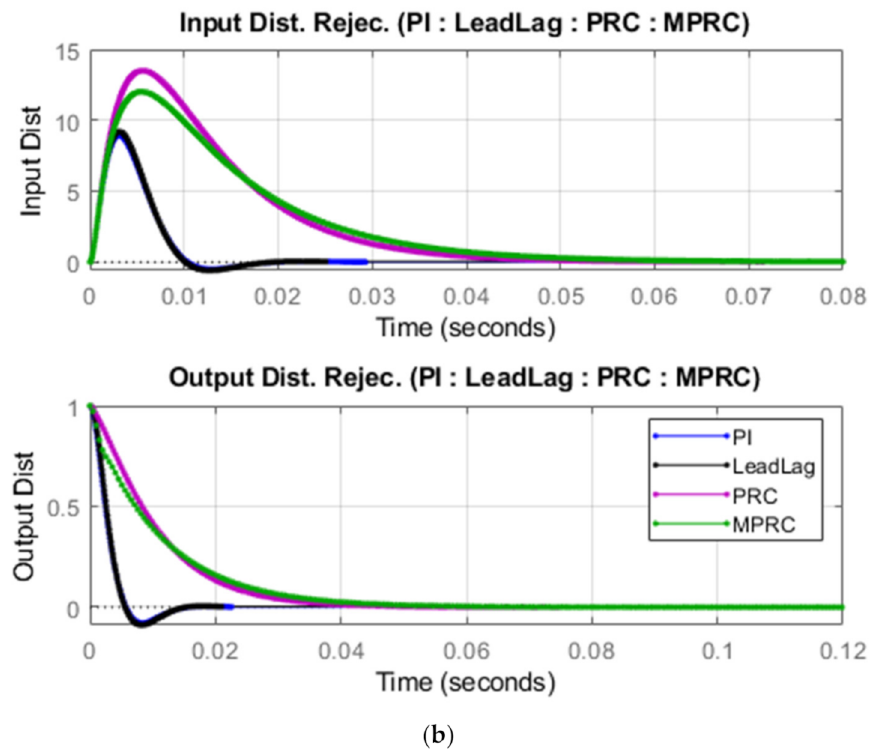
Figure 6. Disturbance rejection; ( a ) block diagram, ( b ) comparison of PI, lead–lag, PRC, and